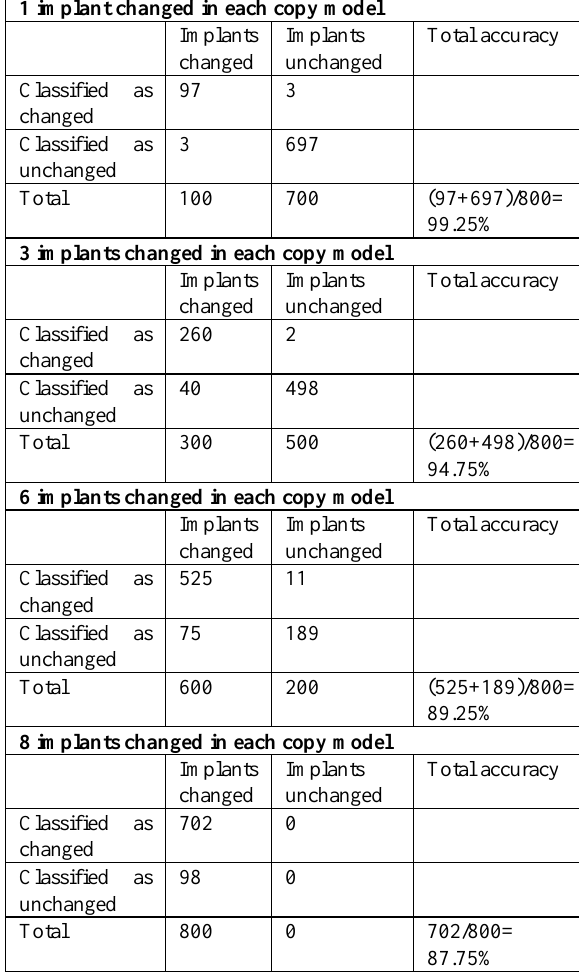
Table 4 – Classification matrix and total accuracy for the identification of changed implants between master and